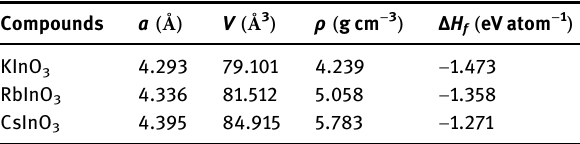
Table 1: Calculated structural properties for XInO 3 ( X = K, Rb,